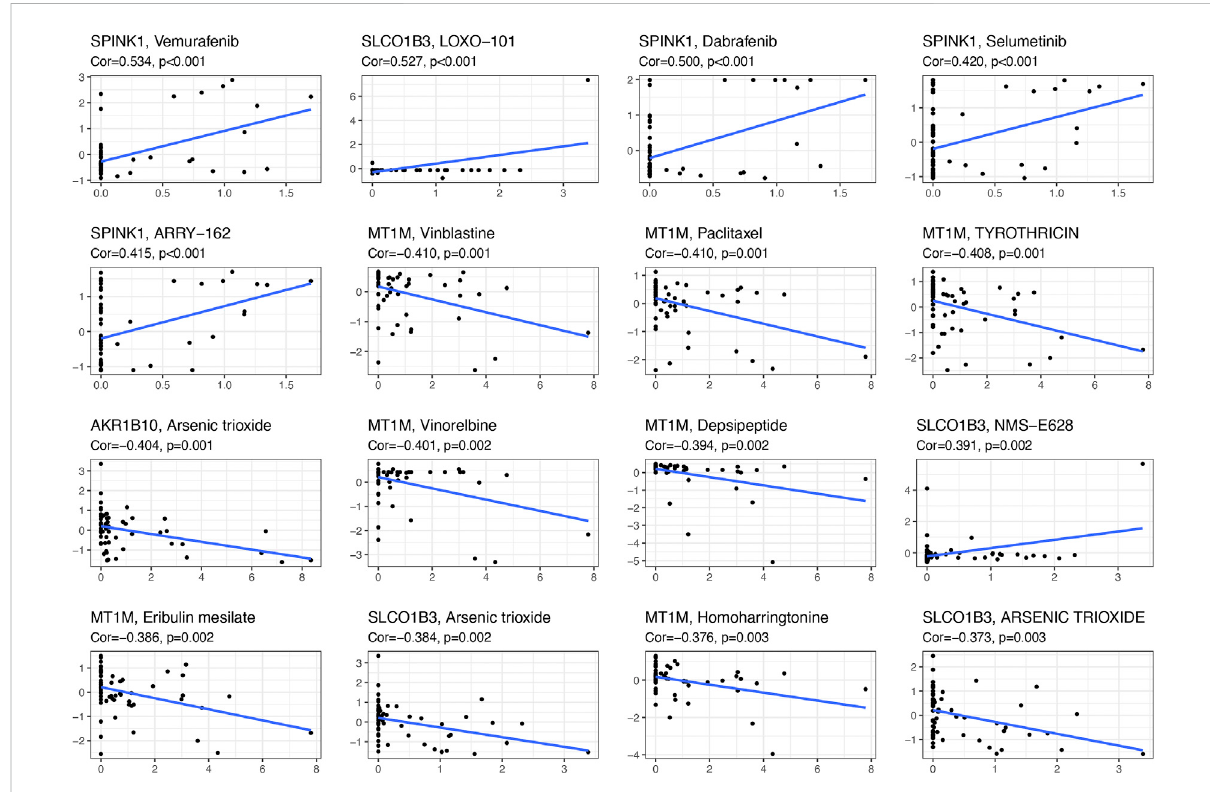
FIGURE 7 Scatter plot of the relationship between diagnostic-related gene expression and drug